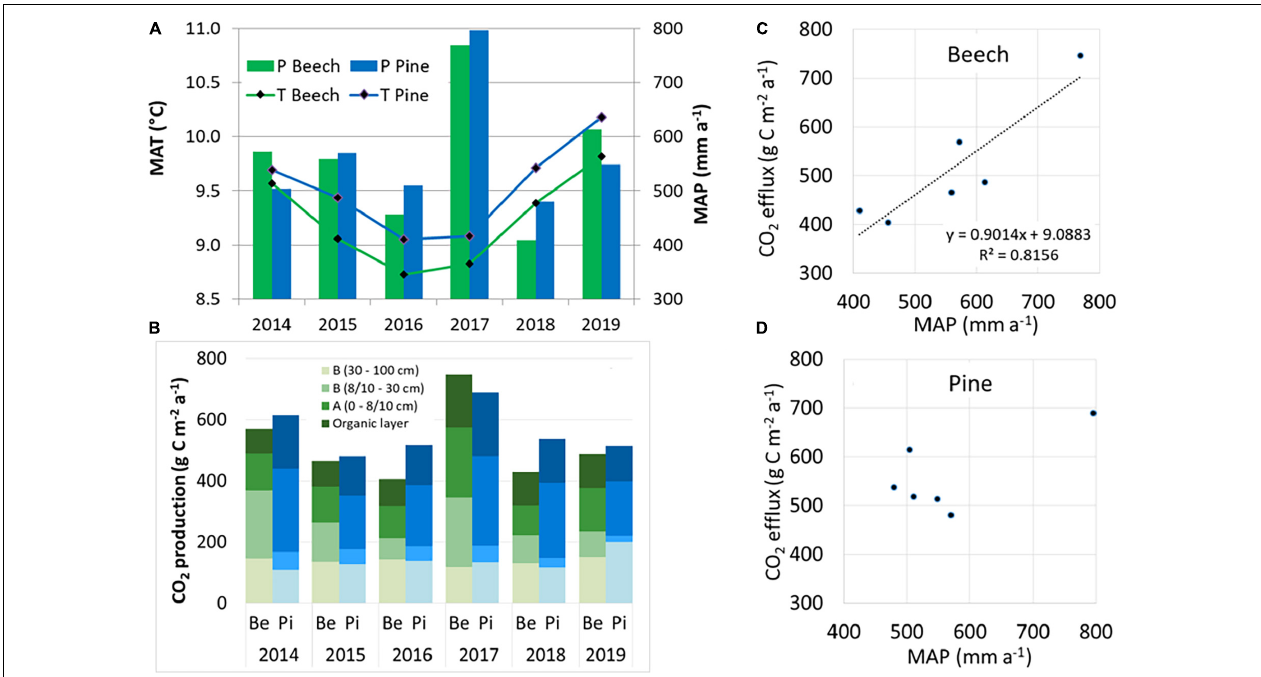
FIGURE 3 | Mean annual air temperature (T) and annual precipitation (P) (A) and mean annual CO 2 production in four soil layers with the sum as the CO 2 efflux (B) of the beech (Be) site and the pine (Pi) site over the years 2014–2019. The relationship between annual CO 2 efflux rates and annual precipitation is indicated for the beech site (C) and pine site (D)